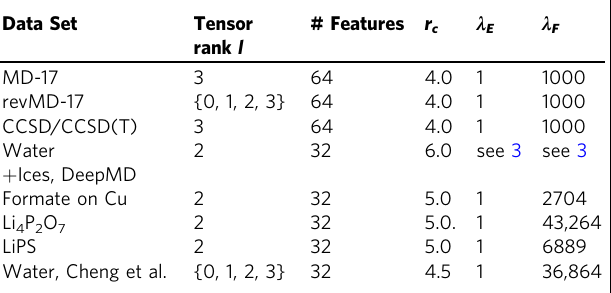
Table 5 Tensor rank l , feature size, radial cutoff in units of [ Å ], as well as energy and force weights used in the joint loss